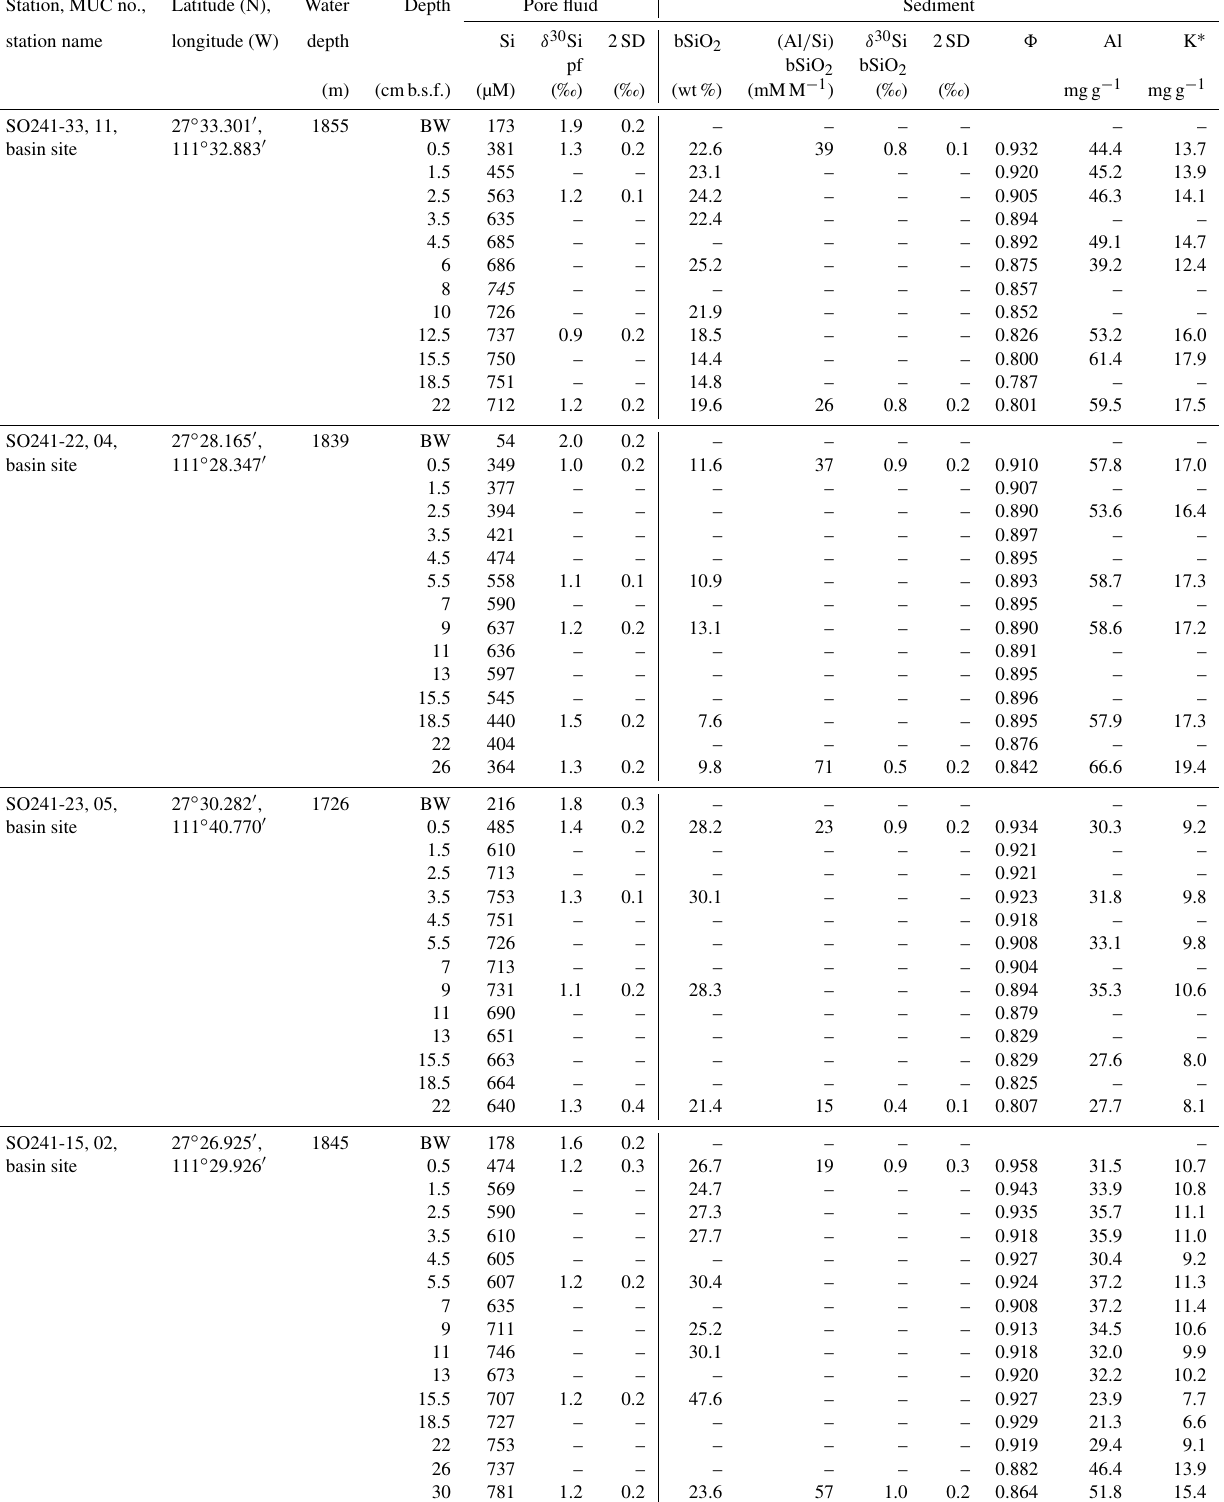
Table 1. Pore fluid Si concentration (µM); δ 30 Si pf values (‰) and biogenic silica weight fraction (bSiO 2 in wt%); Al / Si ratio (mMM − 1 ); δ 30 Si bSiO values (‰); porosity (Ø); and Al and K contents (wt%) for the basin sites, hydrothermal site, and OMZ site. 2 Station, MUC